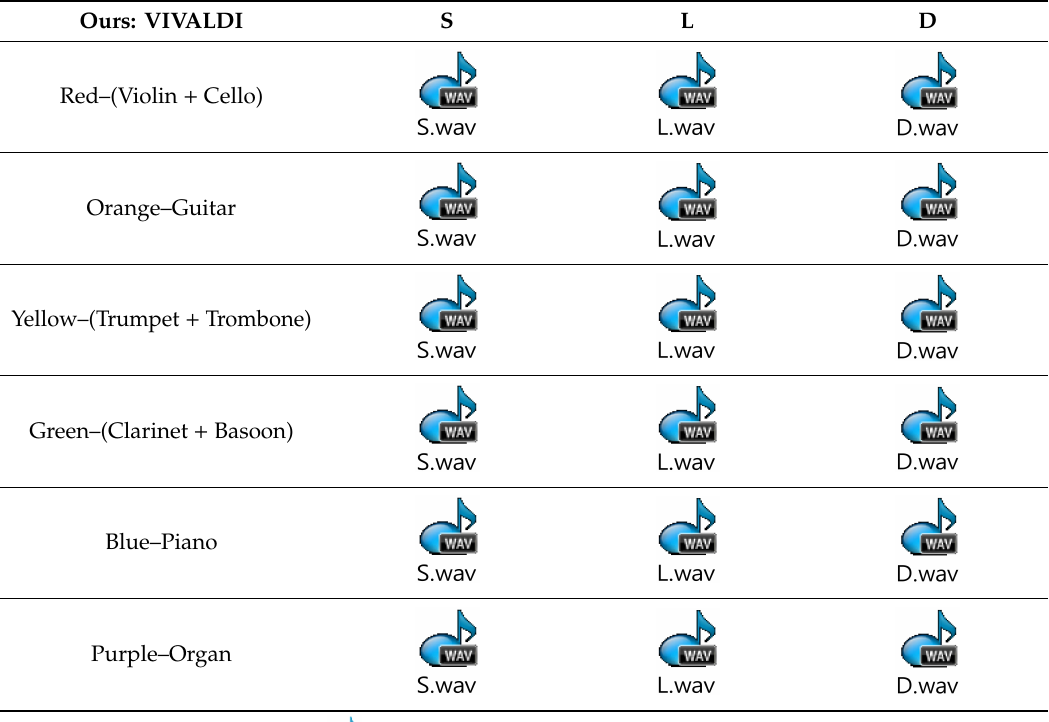
Table 3. VIVALDI SCC set with wav sound